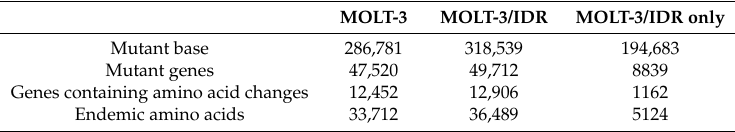
Table 1. Genome Analysis Toolkit (GATK) and SnpEff mutant analysis.